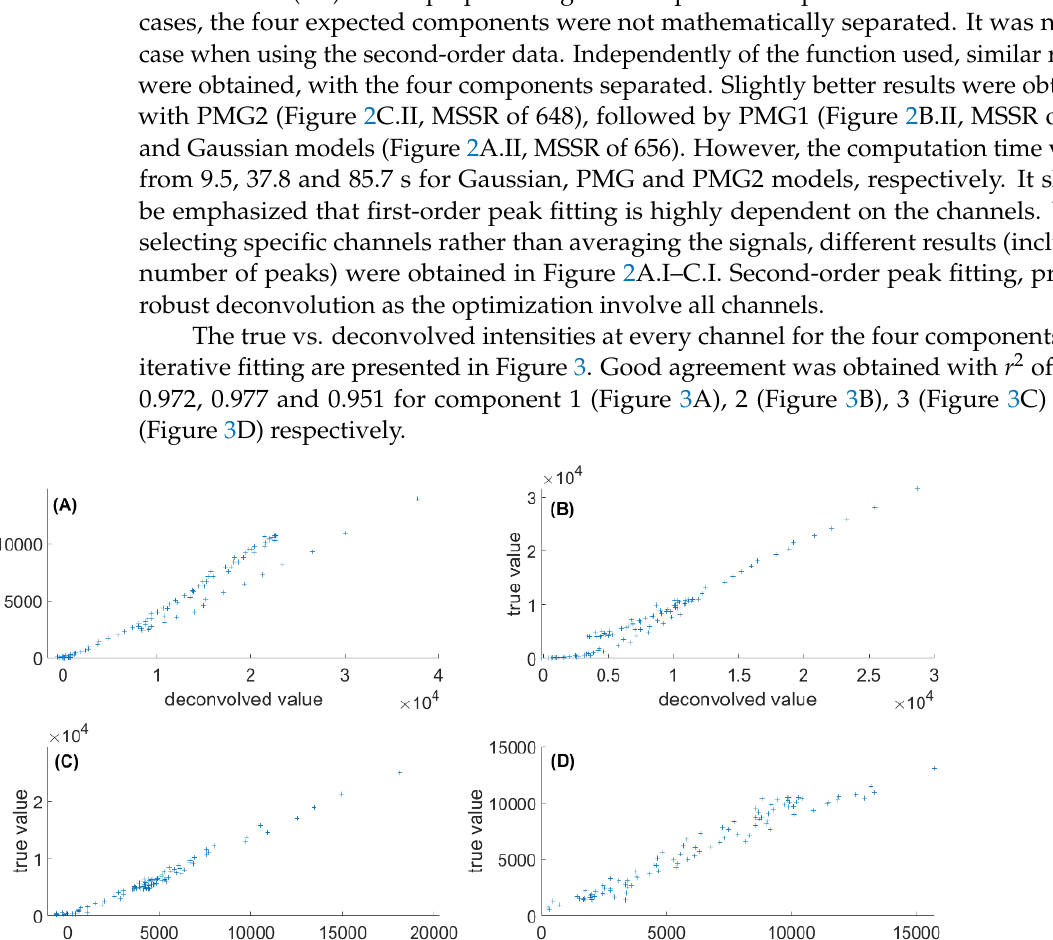
Figure 3. True vs. deconvolved intensities at every channel obtained after itMPF of the D1nh dataset, with ( A – D ) plots of the true vs. deconvolved values for the first, second, third and fourth component in D1nh dataset respectively.